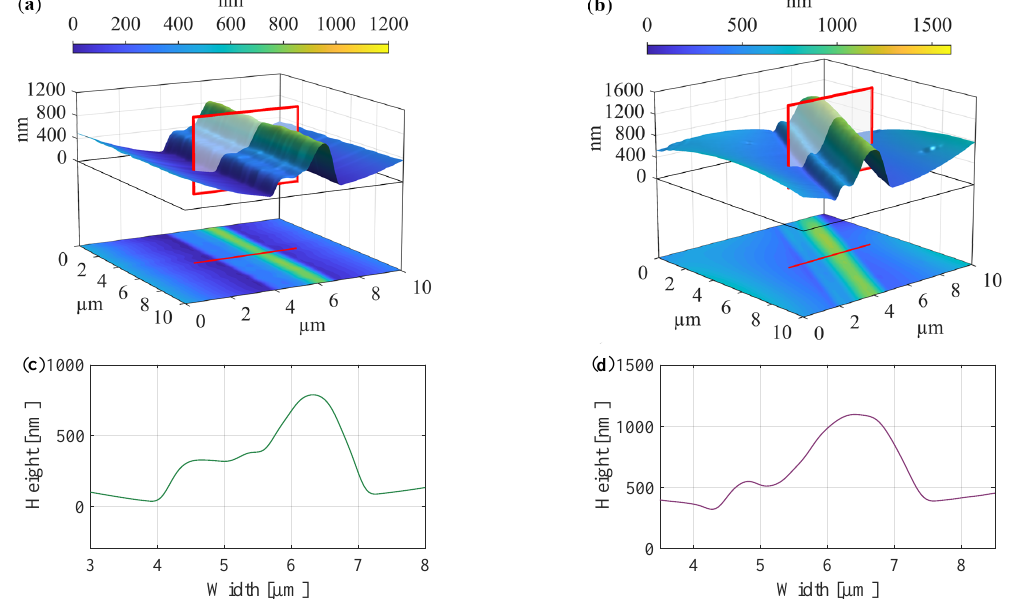
Figure 5. Morphological structure of PVDF nanofibers scanned by AFM with different collector speeds at ( a ) 300rpm and ( b ) 2000rpm, and their software-estimated cross-sections in ( c ) and ( d ),